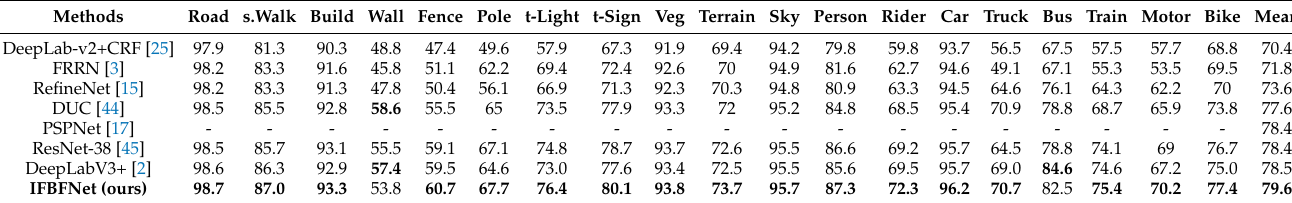
Table 6. Per-class results on the Cityscapes testing set. Our network outperformed existing approaches and achieved 79.6% in MeanIoU.“-” indicates that the methods did not give the corresponding result.The blackened numbers represent the best performing group in this set of data. Methods